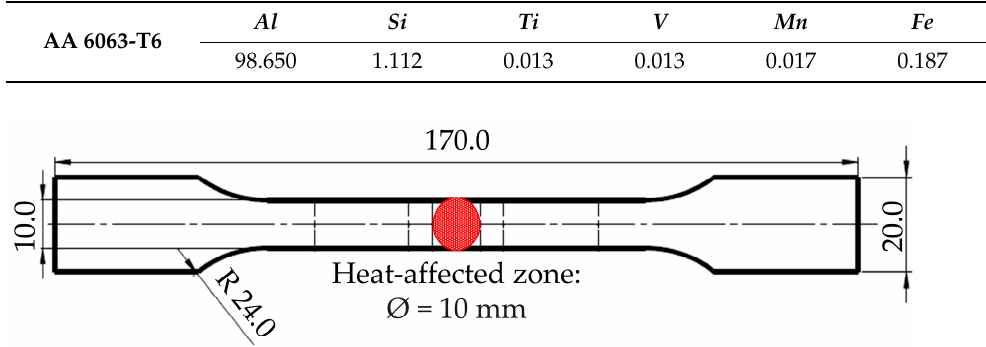
Table 1. Chemical composition of the investigated alloy.